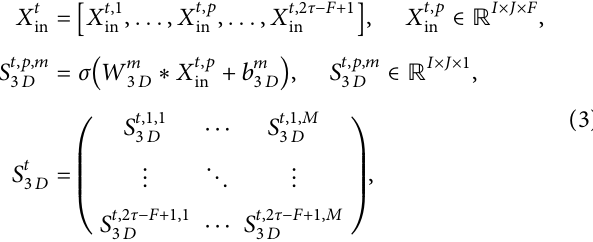
Algorithm 1 outlines the LC-ST-FCN training process.